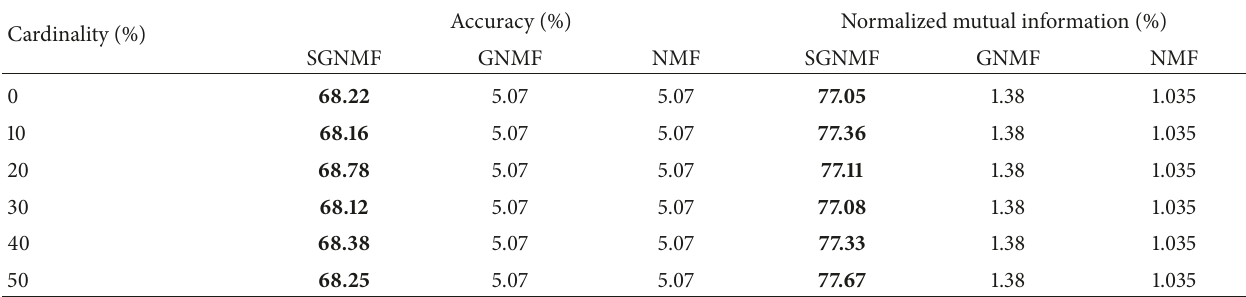
Table 10: Clustering performance on COIL20 in case 2